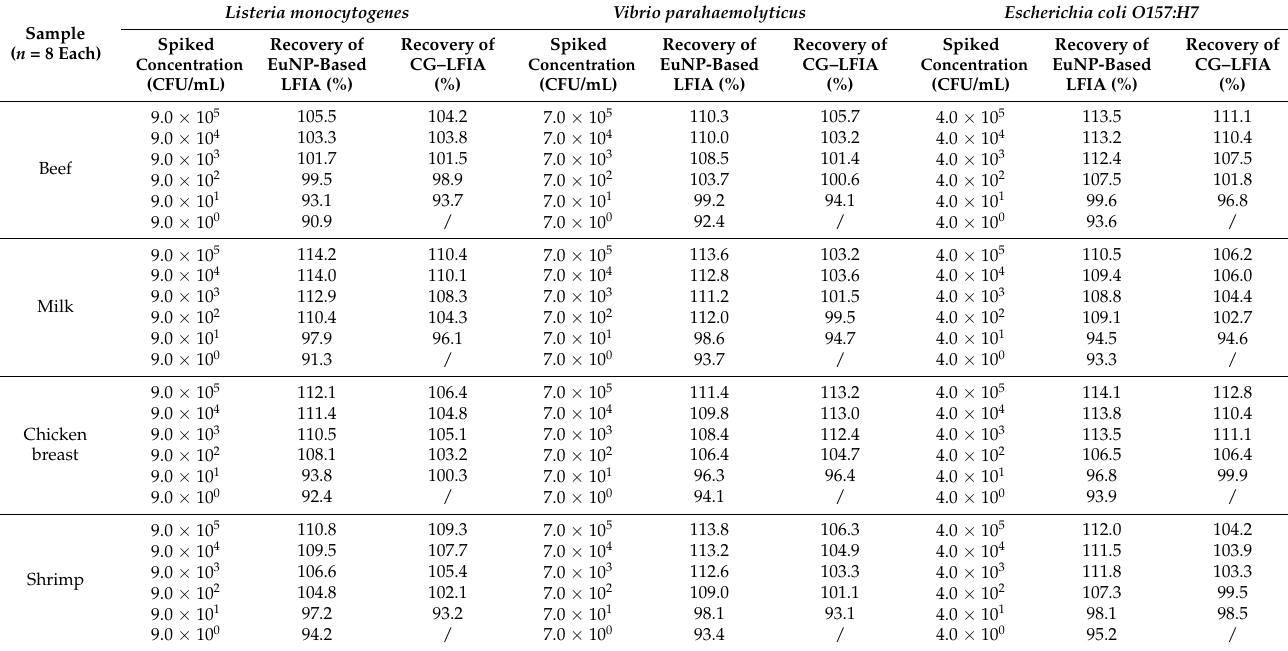
Table 3. Determination results for Listeria monocytogenes , Vibrio parahaemolyticus , and Escherichia coli O157:H7 in spiked samples. CFU: colony-forming unit.